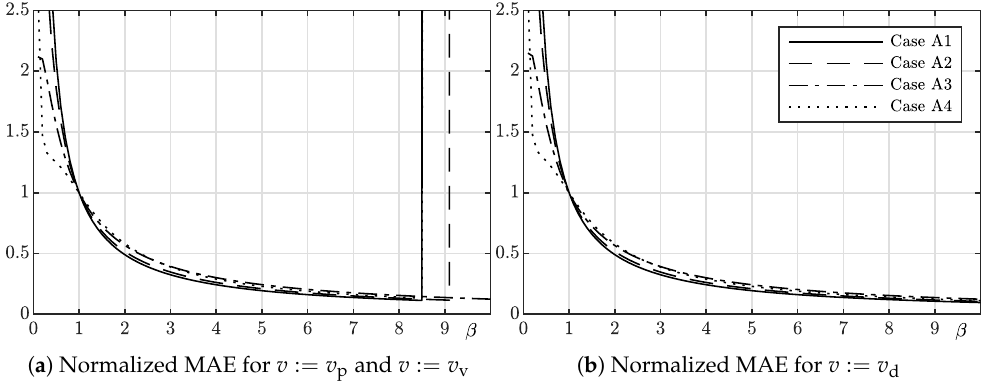
Figure 3. Values of normalized MAE criterion in the simulation of scenario